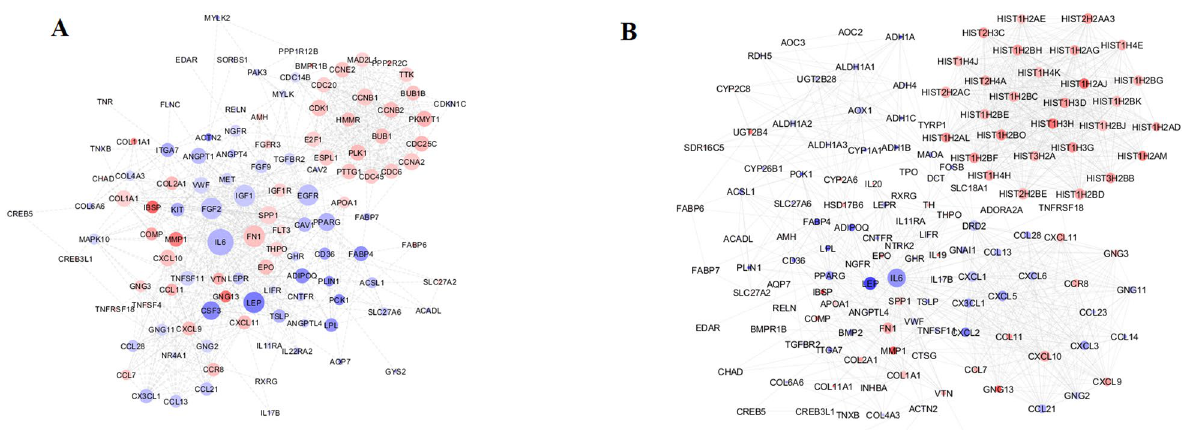
Figure 3. PPI network of breast cancer differentially expressed genes (DEGs) between normal and GATA3 mutant samples in ( A ) the entire patient and ( B ) ER-positive subgroup. The node size is proportional to the degree value as the bigger size means the larger degree value. The color of the node is related to the expression of genes: up regulated genes are shown in Red and down regulated genes are shown in